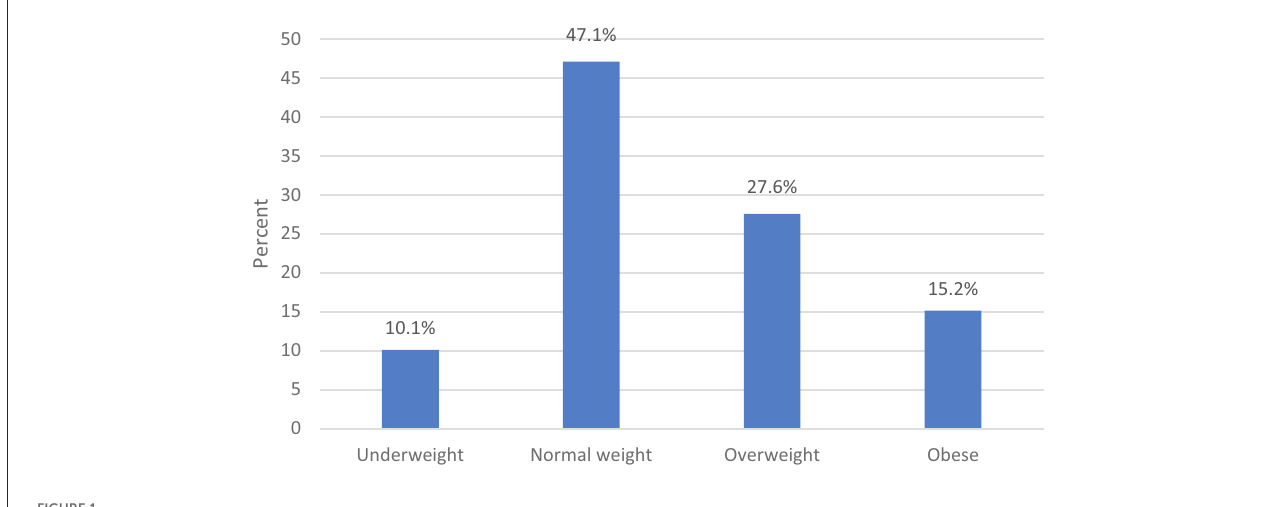
FIGURE1 Participants’ BMI during the COVID-19 lockdown ( n = 1,682).